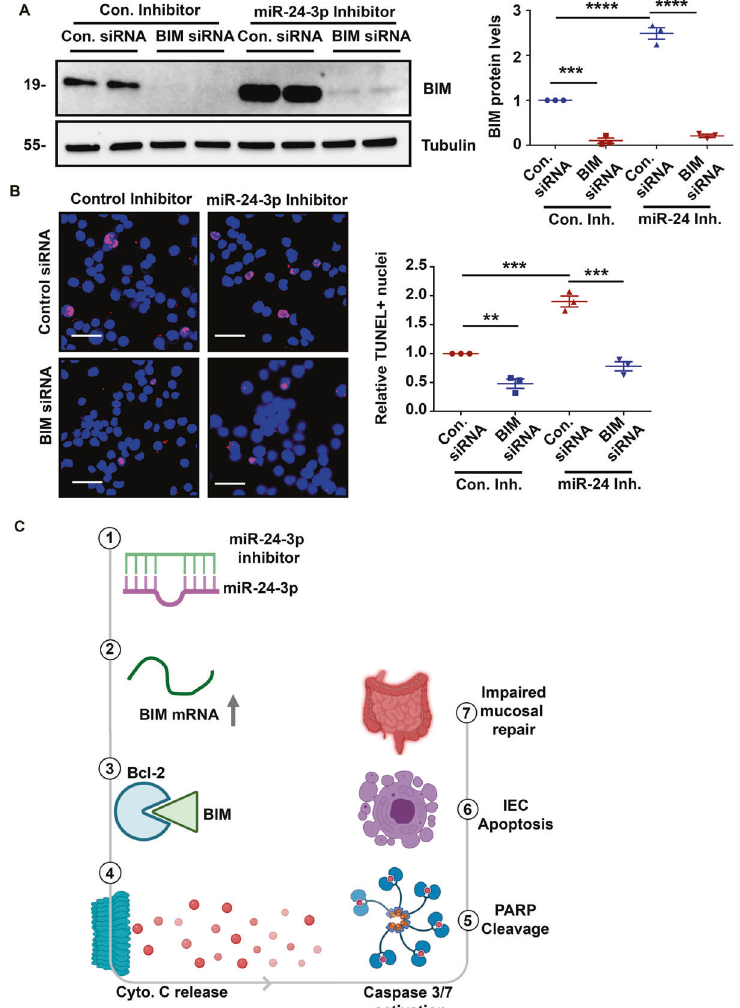
Fig. 8 Downregulation of BIM reduces the induction of apoptosis caused by miR-24-3p inhibition. A Western blots and densitometric analysis of BIM and Tubulin from SW480 cells treated with staurosporine and either control or BIM siRNA plus either control inhibitor or miR- 24-3p inhibitor. Three independent experiments. Mean ± SEM. B A TUNEL assay was used to measure the proportion of apoptotic cells. Magenta cells are TUNEL-positive and non-TUNEL-positive cell nuclei are labeled in blue. Three 250 × 250 µm fi elds were selected for quanti fi cation and are depicted in the graph. Three independent experiments. Mean ± SEM. Scale bars = 50 µm. ** p < 0.01; *** p < 0.001; **** p < 0.0001. C We observed that when miR-24 - 3p was inhibited or removed from the genome (1) the mRNA and protein levels of BIM increase (2). BIM then stabilizes Bcl-2 (3) enabling Bax-mediated Cytochrome C release from the mitochondria (4). Cytochrome C activates caspases which result in events such as PARP cleavage (5). The activated pro-apoptotic enzymes then induce apoptosis in the intestinal epithelium (6). Induction of apoptosis during mucosal repair after colitis worsens outcomes